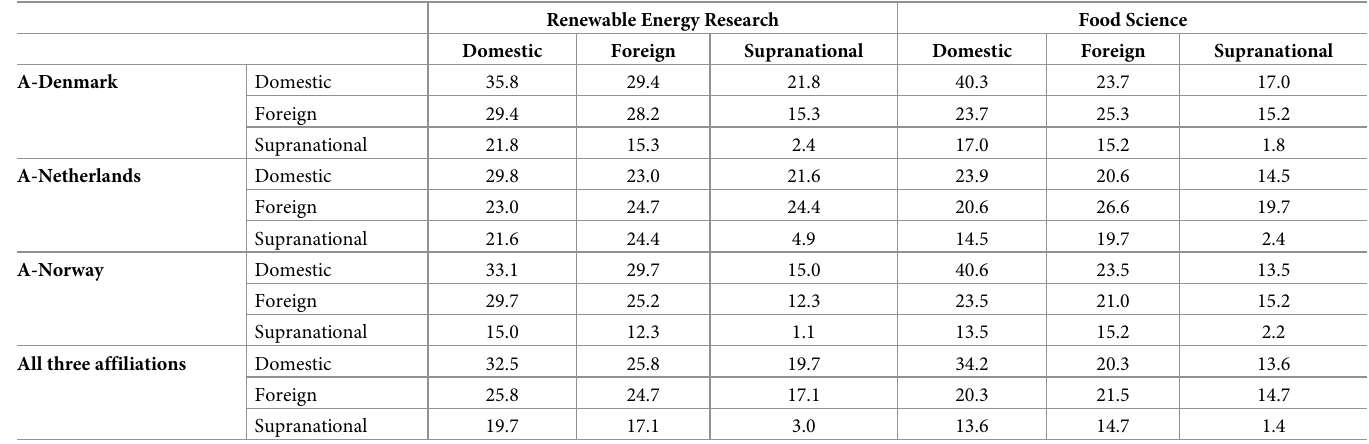
Table 7. Patterns of funding amalgamations by funding origin,